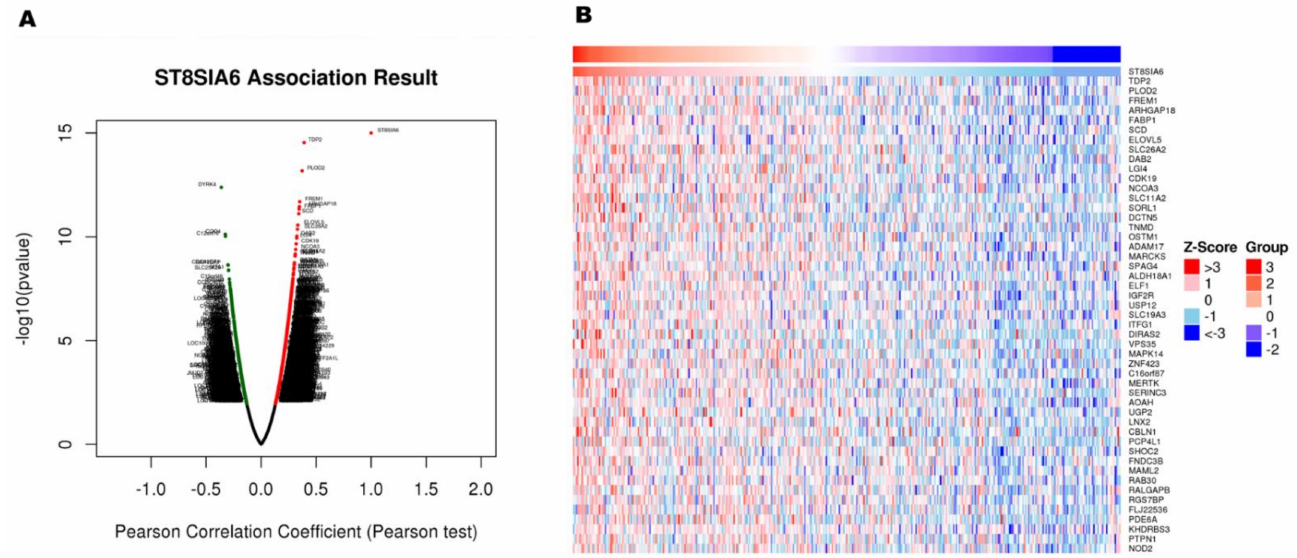
Figure 3. Using LinkedOmics to identify the relationship between genes differentially expressed and ST8SIA6 correlations in colon cancer. ( A ) Pearson correlation coefficient used to analyze correlations between ST8SIA6 and differentially expressed genes in colon cancer. ( B ) Heat maps representing the genes positively correlated with ST8SIA6 in colon